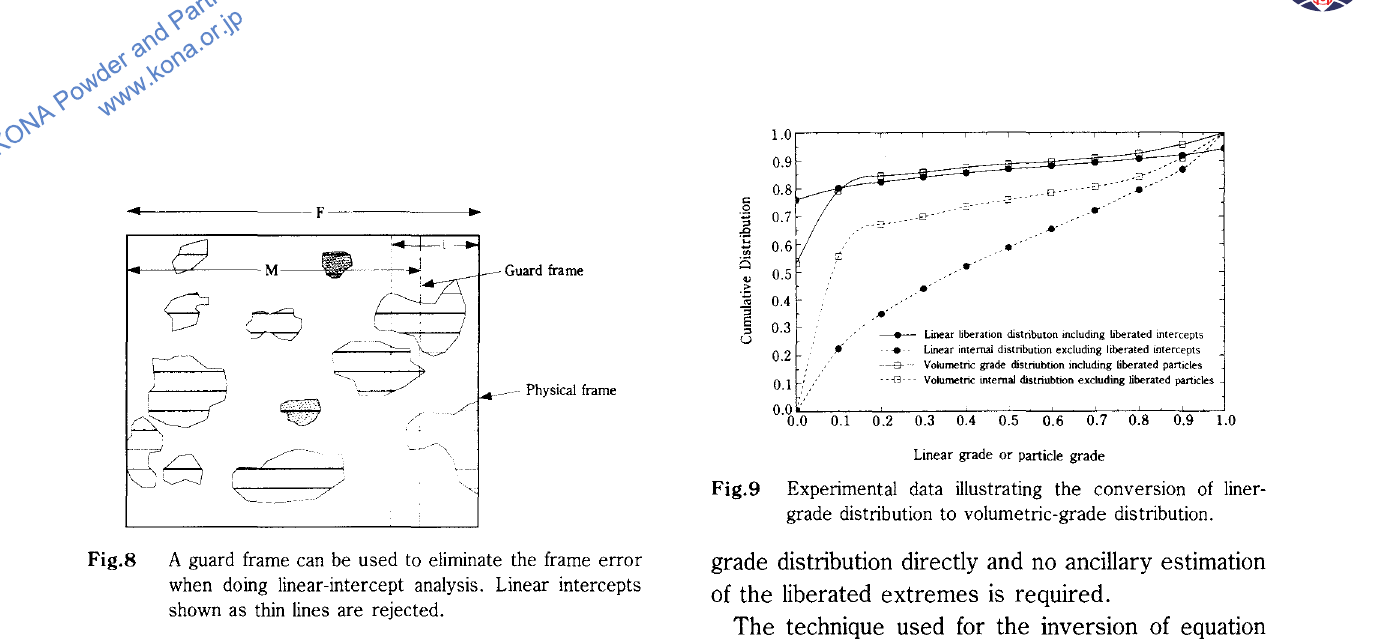
Experimental data illustrating the conversion of liner grade distribution to volumetric-grade